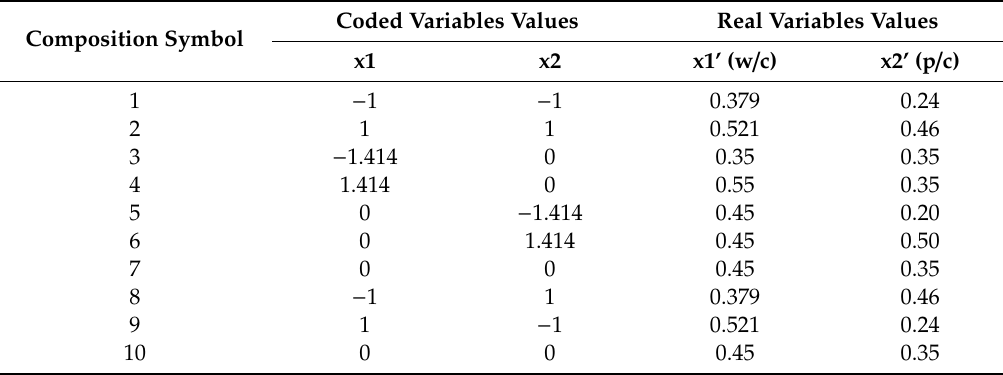
Table 5. Range of variables used in